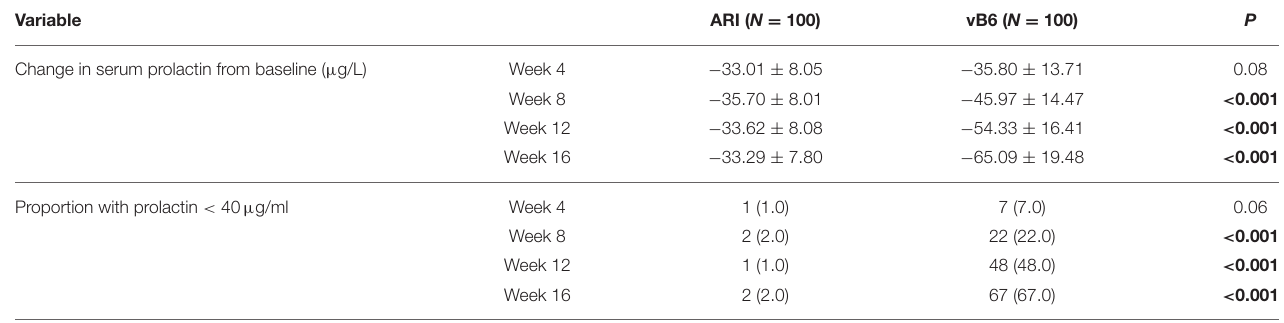
TABLE 2 | Prolactin levels from baseline through week 16 in men with TRS.